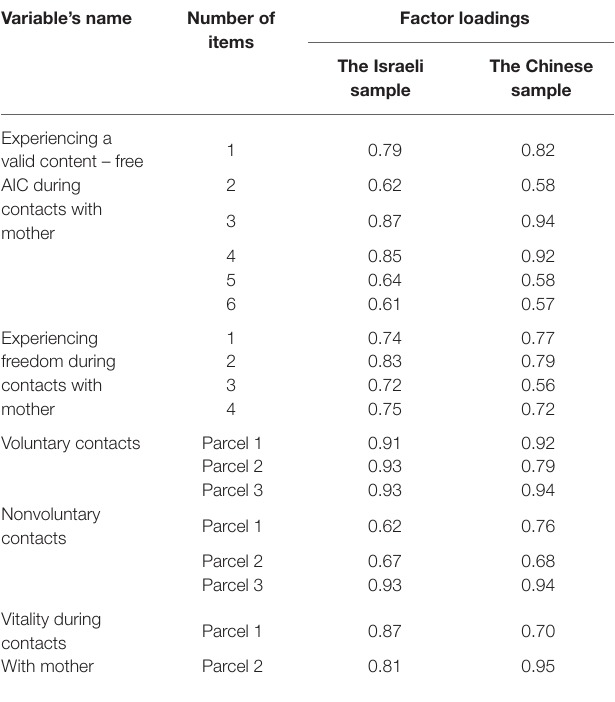
TABLE 1 | Results of the measurement model for the Israeli and Chinese